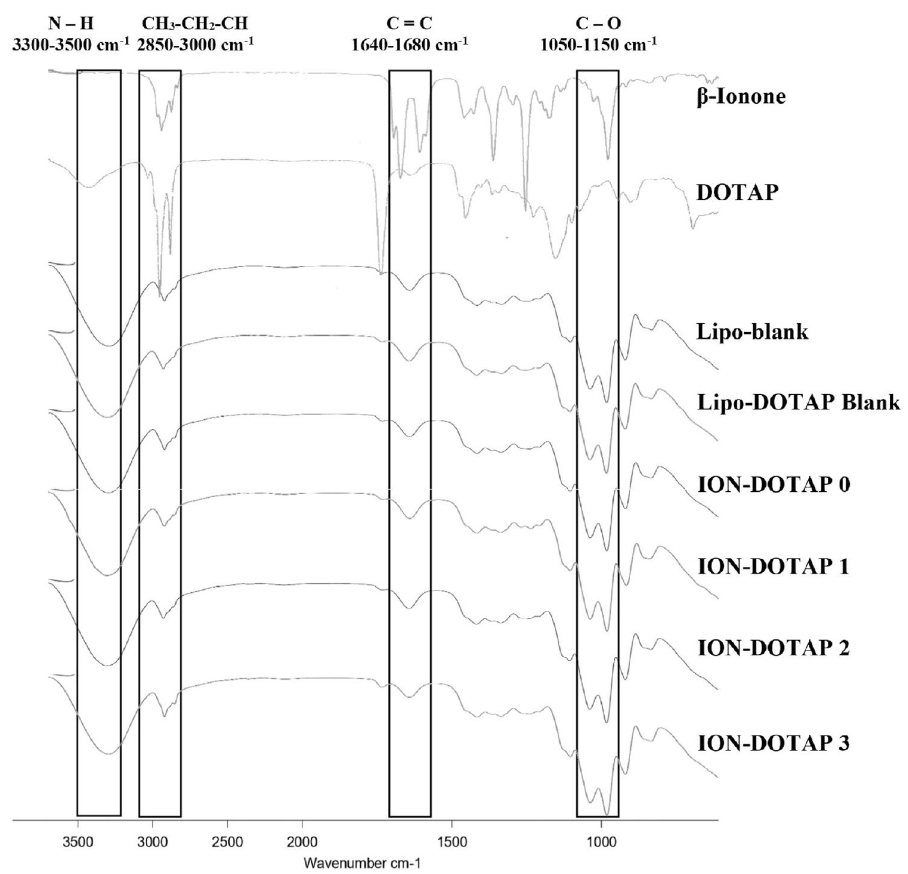
Figure 4. FTIR spectra of β-ionone, DOTAP, , ION-DOTAP liposomes, and Lipo-DOTAP Blank, ION- DOTAP 1, ION DOTAP 2, ION DOTAP 3 Lipo-Blank contained no DOTAP or β-ionone, while Lipo-DOTAP 3contained DOTAP at the highest concentration without the addition of